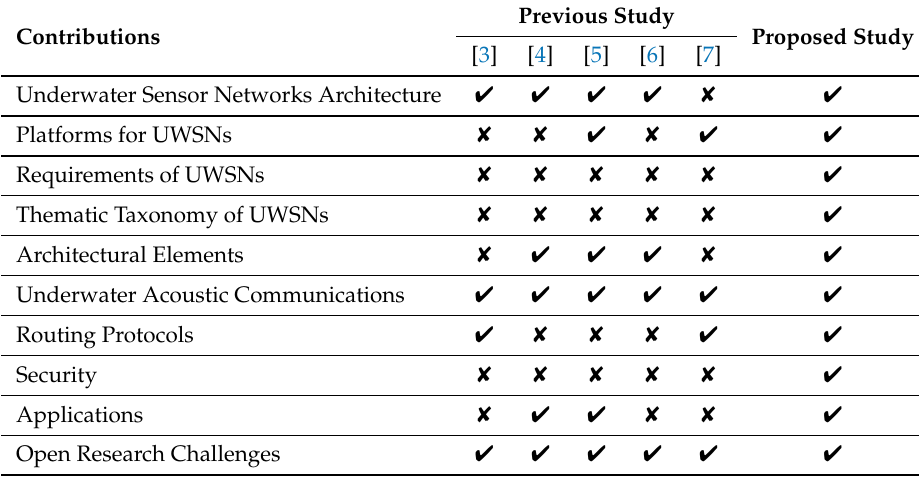
Table 1. Comparison of the Proposed Paper with the Existing Surveys in